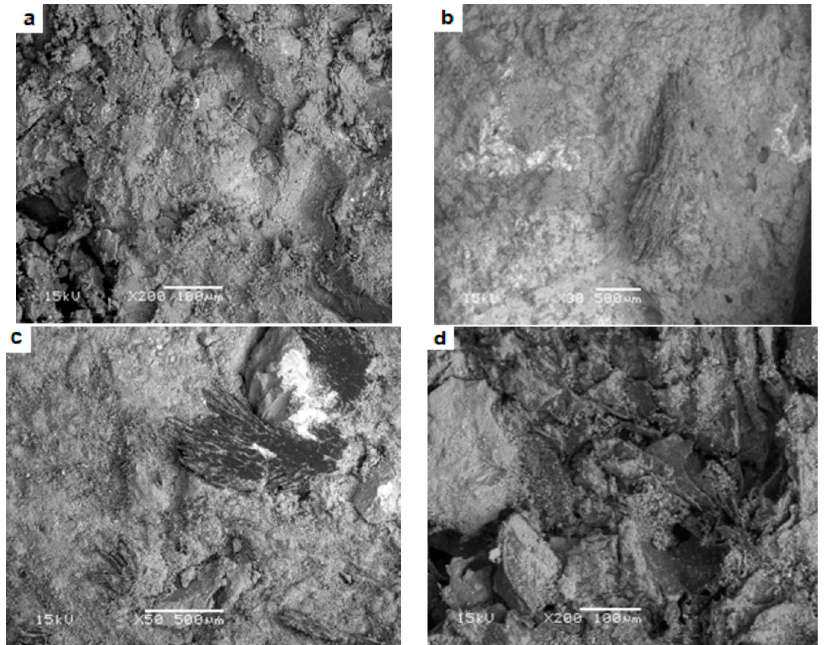
Figure 8. SEM micrographs of adobes reinforced with sugarcane bagasse (( a ) 0 wt.%; ( b ) 1 wt.%; ( c ) 4 wt.%; ( d ) 5 wt.%).